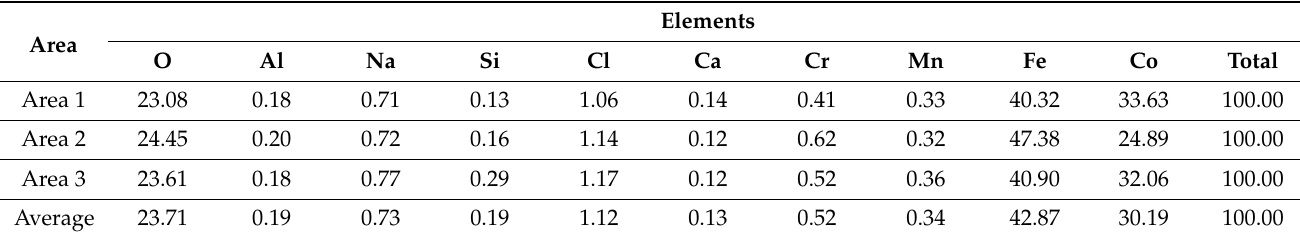
Figure 14. X-ray fluorescence spectrum of CoFe 2 O 4 /PEI. The full scale of 32,642 pulses. The cursor is 0.257 (3640 pulses). Table 4. Data of elemental analysis of CoFe 2 O 4 /PEI (in wt.%). Parameters of processing: all elements were analyzed